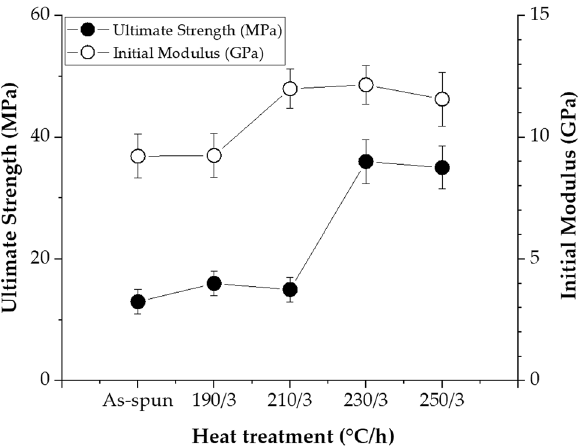
Figure 11. Tensile properties of TLCP fibers with various heat treatment temperatures at a constant annealing time.